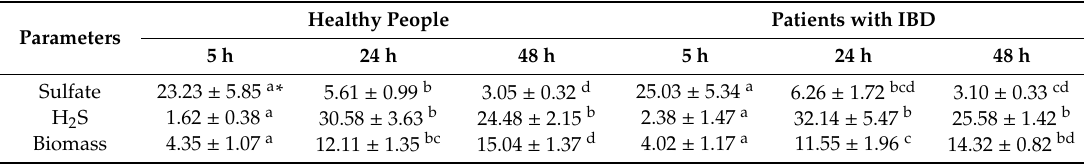
Table 4. Statistical analysis of sulfate reduction parameters and biomass accumulation of intestinal SRB strains.